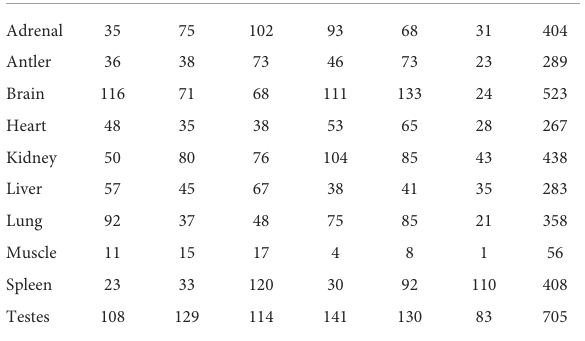
TABLE 2 Characteristic pathways and biological processes of the organs as demonstrated by the organ-enriched target genes of DE miRNAs.